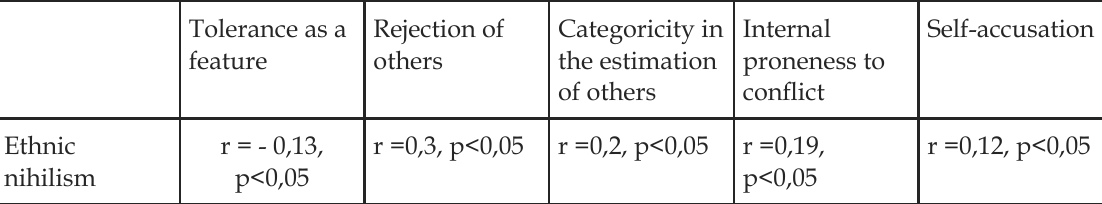
Tab. 3. The correlation of ethnic nihilism with the scales of tolerance and